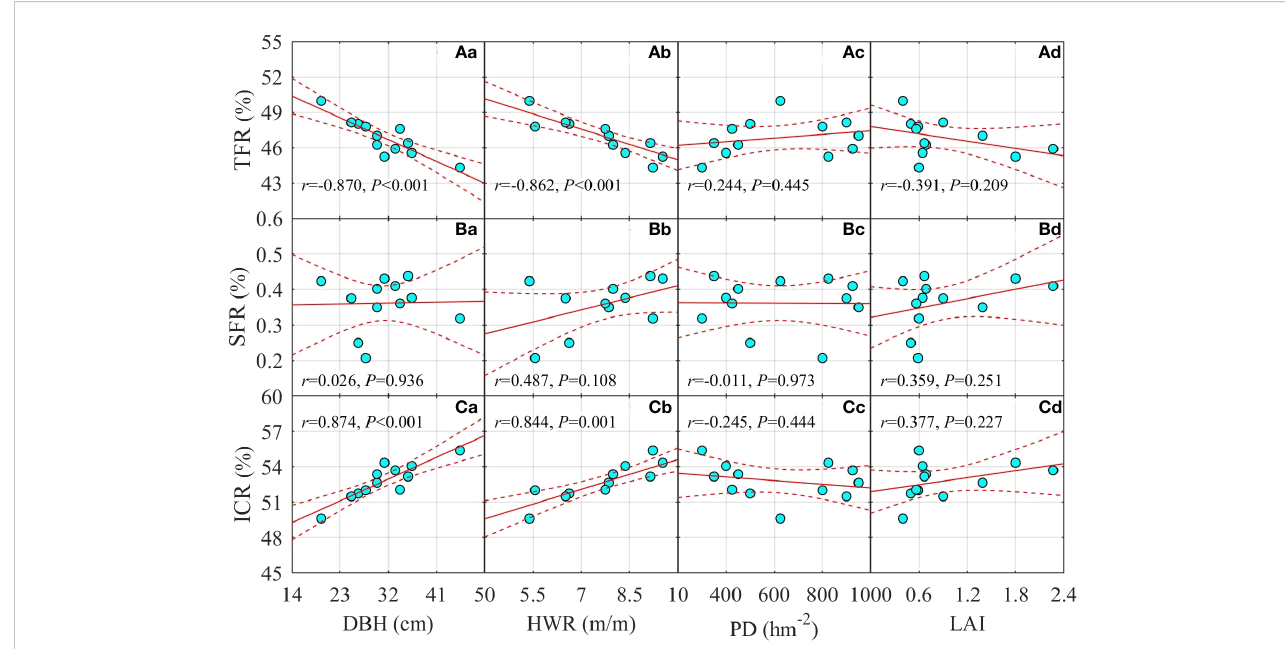
FIGURE 4 Changes in the crown throughfall, stem fl ow, and interception ratio (TFR, SFR, and ICR) of Picea schrenkiana with DBH, crown height-to-width ratio (HWR), population density (PD, hm − 2 ), and leaf area index (LAI) on the northern slope of Mount Bogda, Tianshan Range, Xinjiang, China ( N = 12). Dashed lines are the upper and lower 95% predicted intervals.